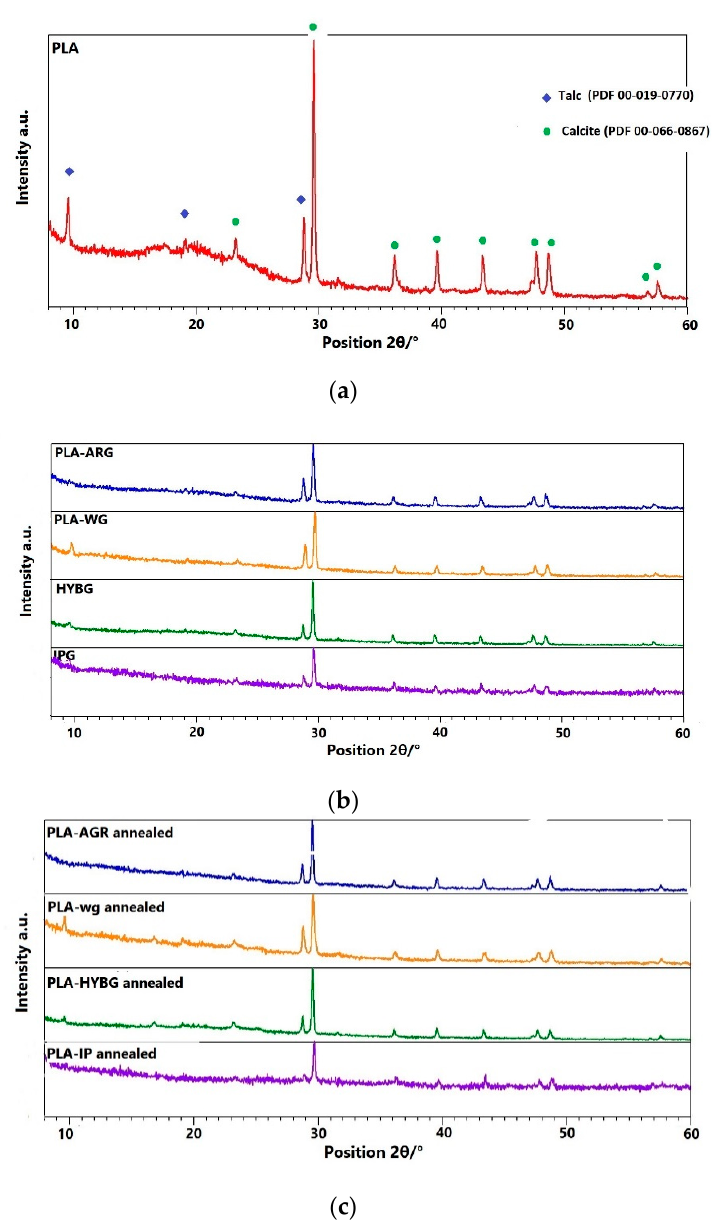
Figure 1. Diffraction patterns of ( a ) neat PLA, ( b ) as prepared and ( c ) heat-treated PLA–glass composites.